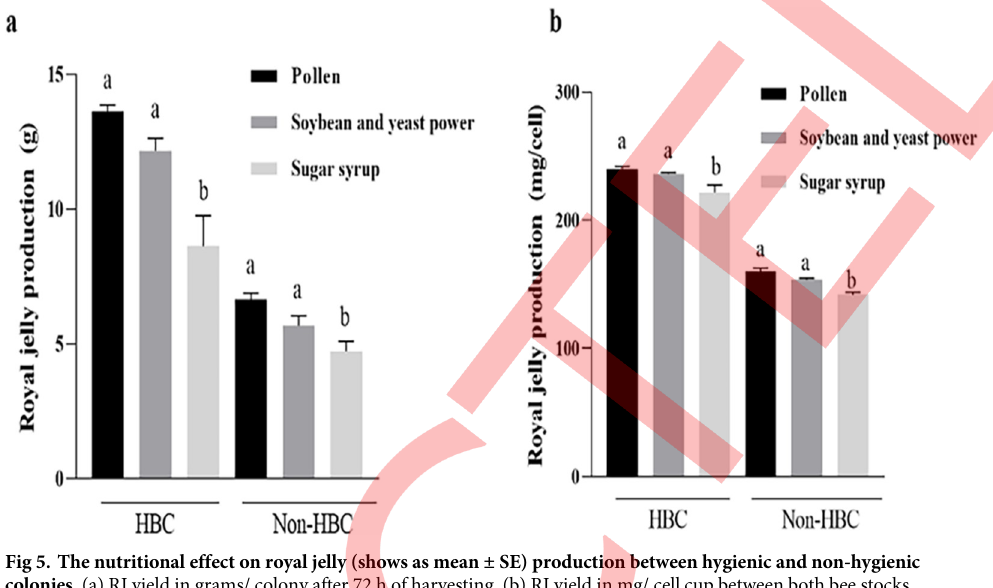
Fig 5. The nutritional effect on royal jelly (shows as mean ± SE) production between hygienic and non-hygienic colonies. (a) RJ yield in grams/ colony after 72 h of harvesting, (b) RJ yield in mg/ cell cup between both bee stocks.